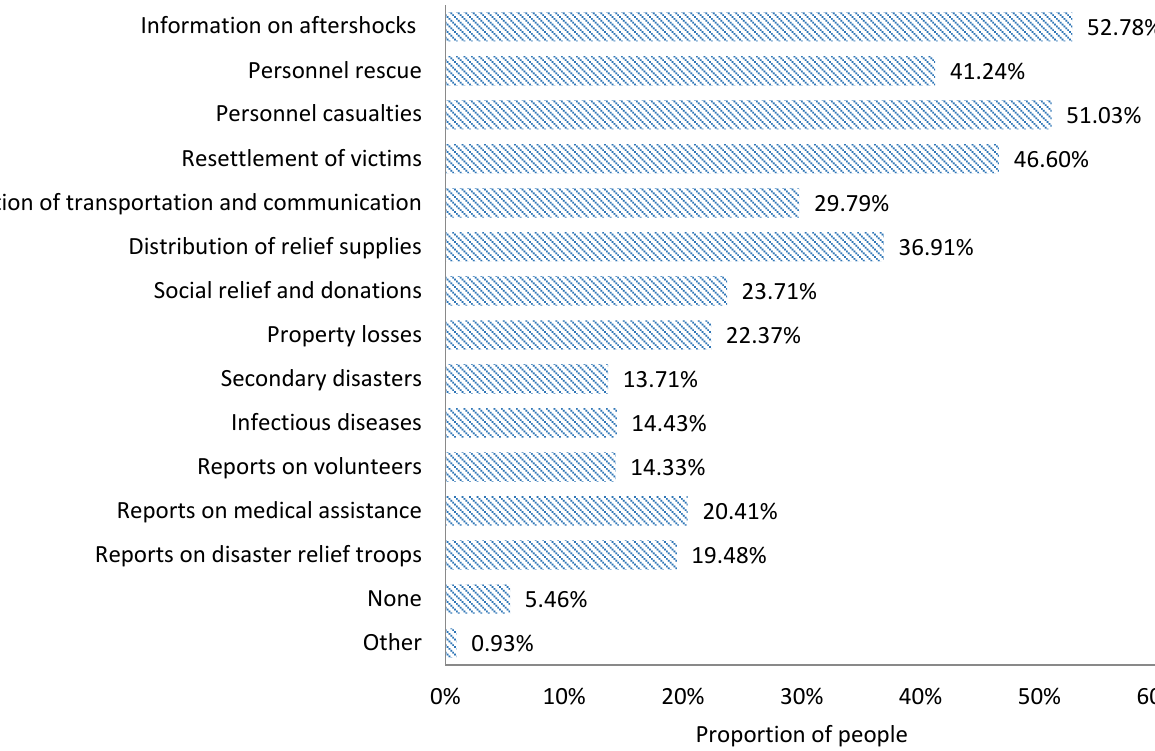
Figure 7. Information actually acquired by the public in the chronic stage of an earthquake disaster.